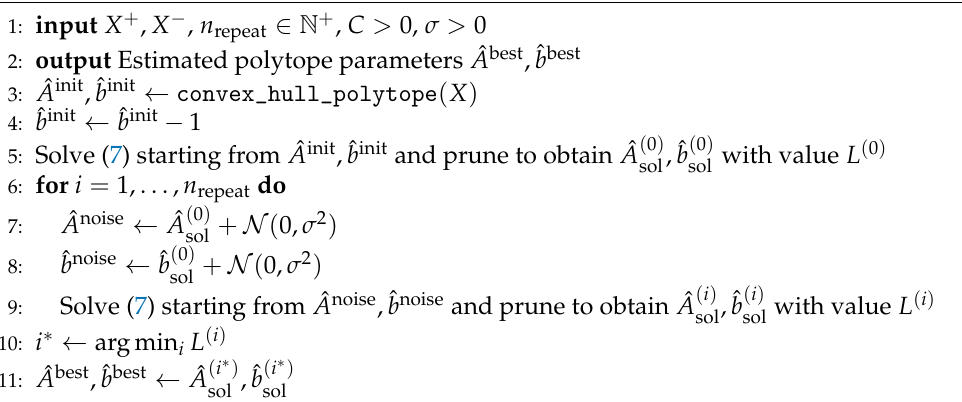
Algorithm 1 Algorithm for approximate solution of the polytope estimation